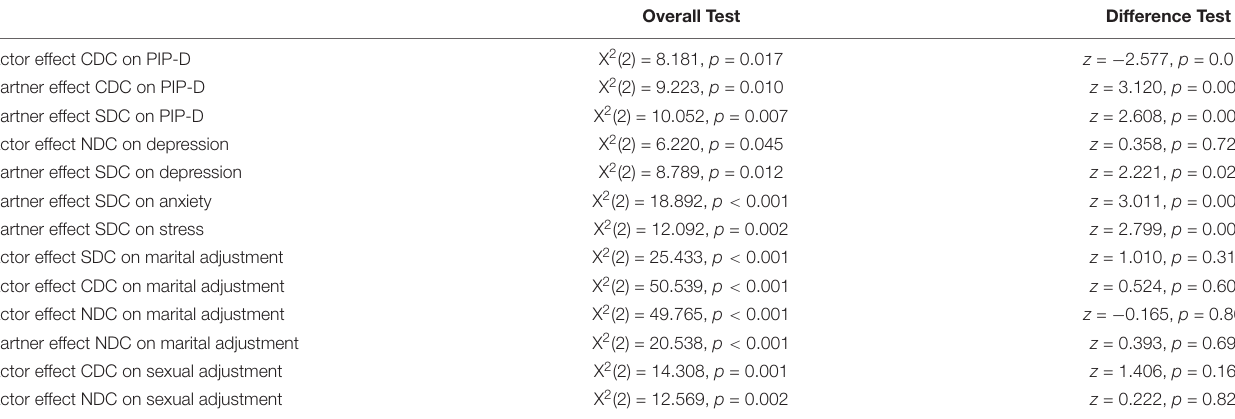
TABLE 3 | APIM analyses.